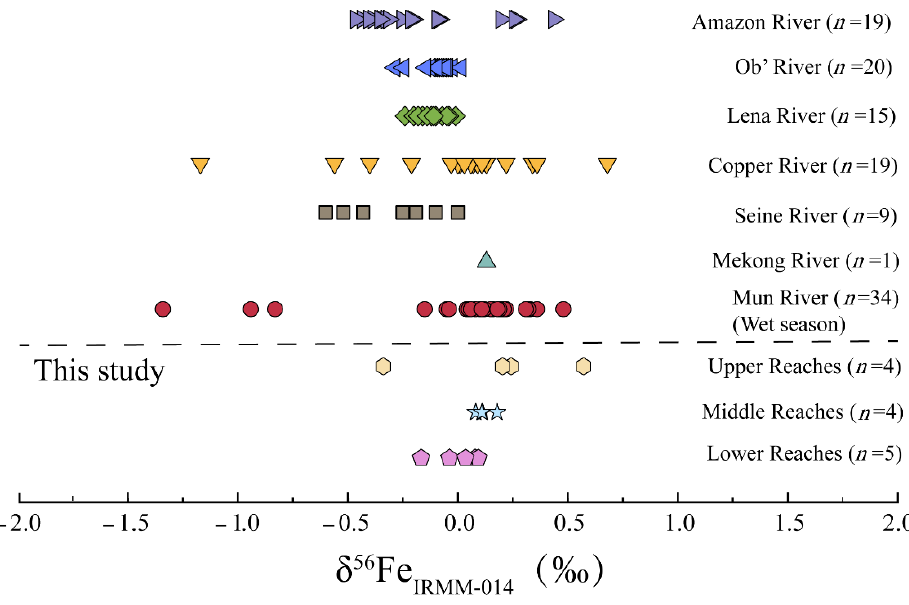
Figure 6. The δ 56 Fe of MR and other world rivers. These data come from